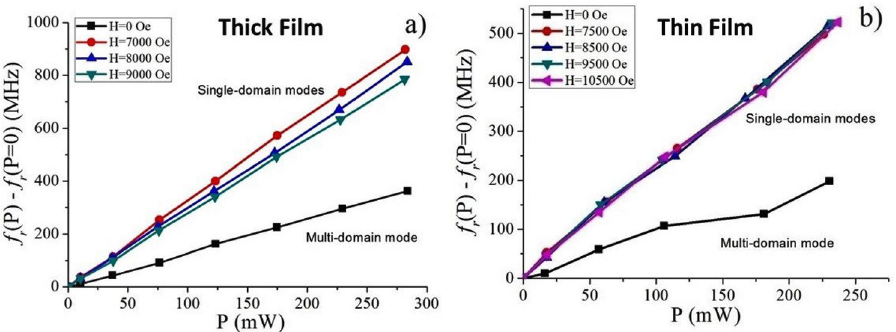
Figure 4. Frequency shift for FMR in the multi-domain and single-domain states as a function of applied DC power for ( a ) thick film and ( b ) thin-film of barium hexaferrite for the current flowing in the basal plane.